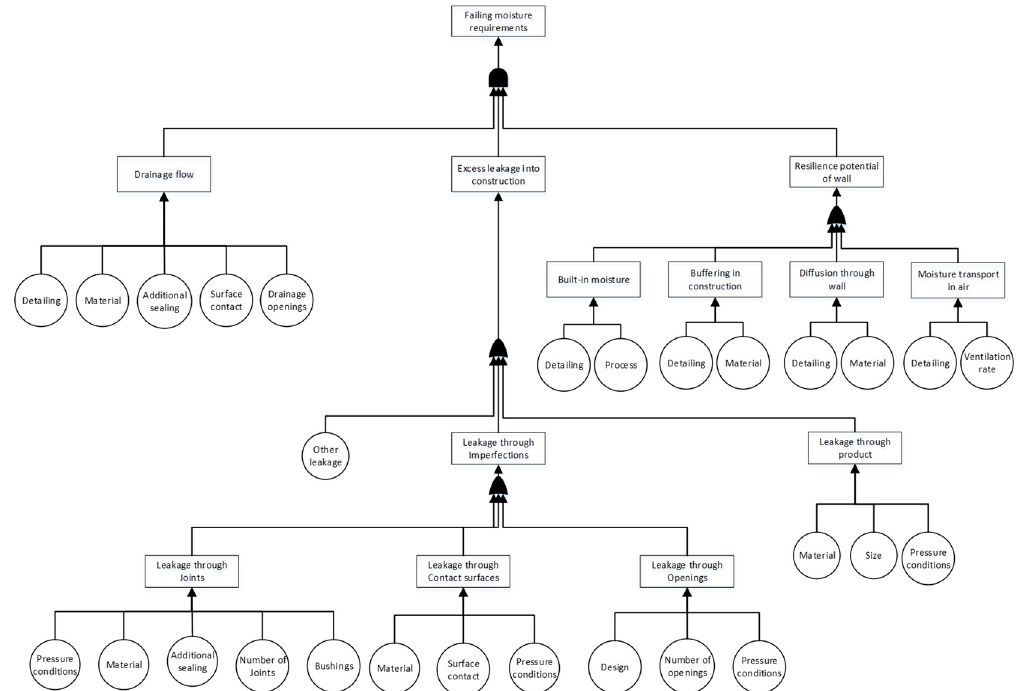
Figure 5. Fault tree for the event: Failing moisture requirements. The three risk clusters: Leakage: through joints; Leakage: Connections to panels and Water trapping: Panel, can be seen as well as other sources of leakage and resilience factors.